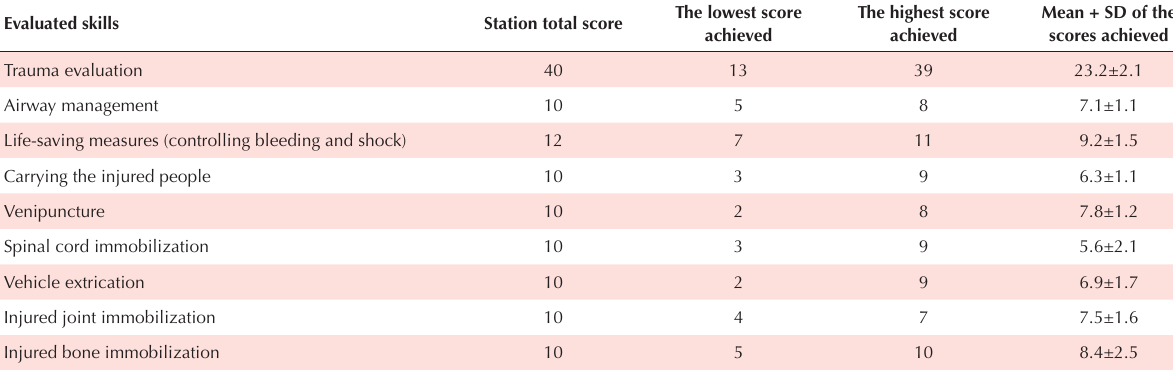
Table 2 . Average performance scores of the skills examined using the OSCE test Evaluated skills